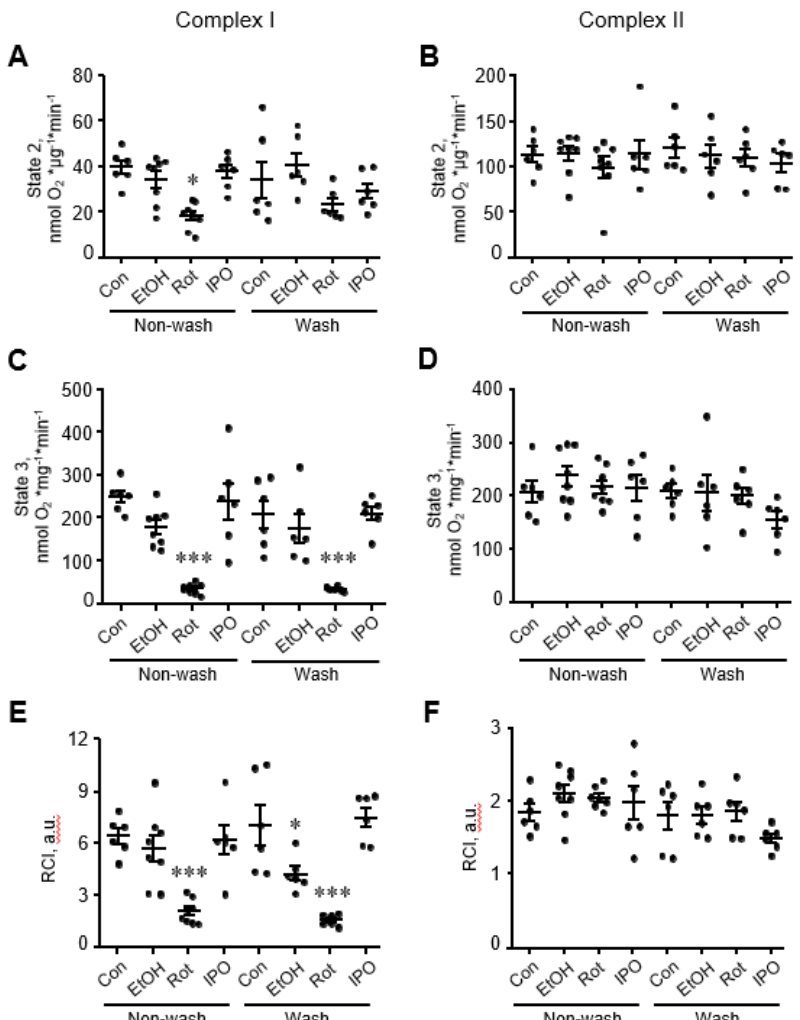
Figure 2. Mitochondrial respiration rates for electron transport chain (ETC) complexes I and II. State 2 ( A , B ), state 3 ( C , D ), and respiratory control index (RCI) ( E , F ) for complexes I and II. Mitochondrial respiration rates were measured in isolated mitochondria using substrates for complexes I ( α -ketoglutarate and L-malate) and II (succinate) in the absence (state 2) or presence of ADP (state 3). Oxygen consumption rates are presented in nmol oxygen / min per mg of mitochondrial protein. RCI by Lardy was calculated as the ratio of state 3 to state 2. Con, control; EtOH, ethanol; IPO, isopropanol; Rot, rotenone. * p < 0.05, *** p < 0.001 vs. Con, n = 6–8 per group.